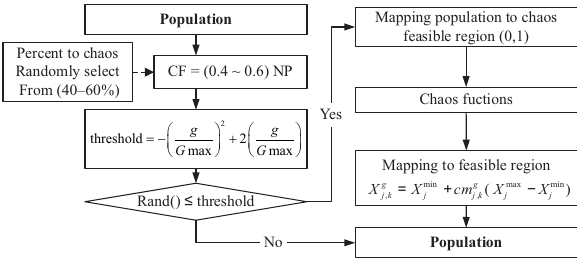
Fig. 2. Chaotic approach